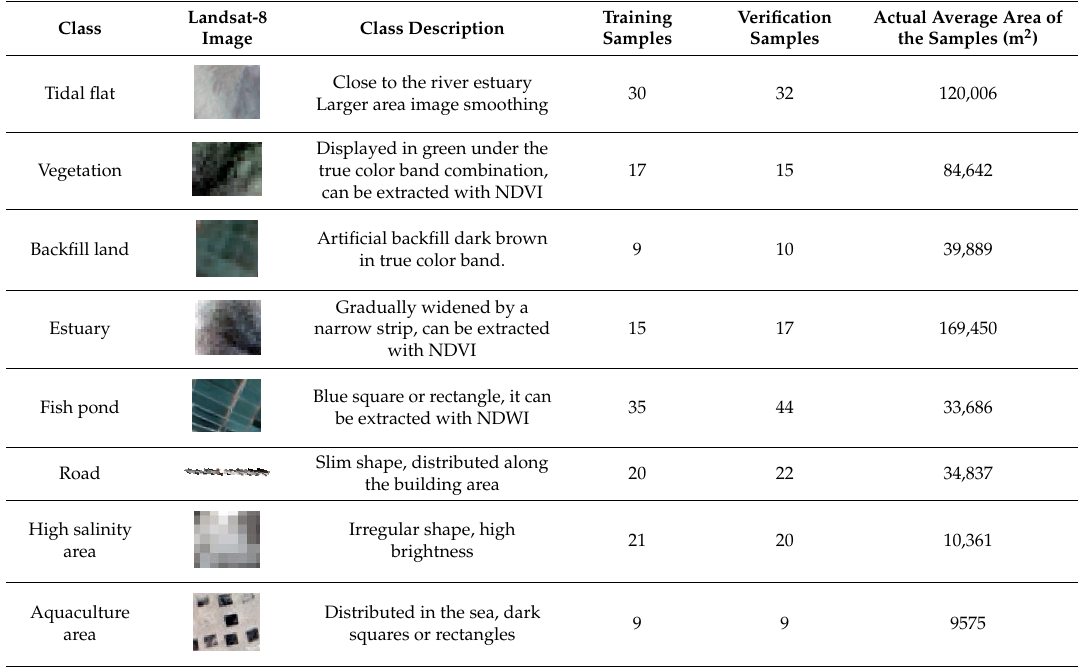
( d ) Figure 2. Worldview-2 and landsat-8 training sample and verification sample distribution. ( a ) Worldview-2 training sample; ( b ) Worldview-2 verification sample; ( c ) Landsat-8 training sample; and ( d ) Landsat-8 verification sample. 2.4. Segmentation The experiment began with a determination of the segmentation scale, in the image, each segmented object corresponded to the actual feature as much as possible. Specific object types could be expressed by one or several objects. The shape of the object boundary should not be overly broken, the spectral differences of objects in the same class should be small, and the boundaries of features should not be blurred [51]. Image segmentation and subsequent selection of experimental features, classification, and assessment of accuracy were completed in eCognition. Several key parameters were set during multi-scale segmentation, including shape, compactness, and scale. The sum of shape and color is 1, with shape determining the proportion of image spectral (color) information and object shape information in the segmentation process. If the shape is 0.3, for example, then color is 0.7. The sum of smoothness and compactness is also 1, with compactness controlling how much the object’s shape tends to be spatially compact versus